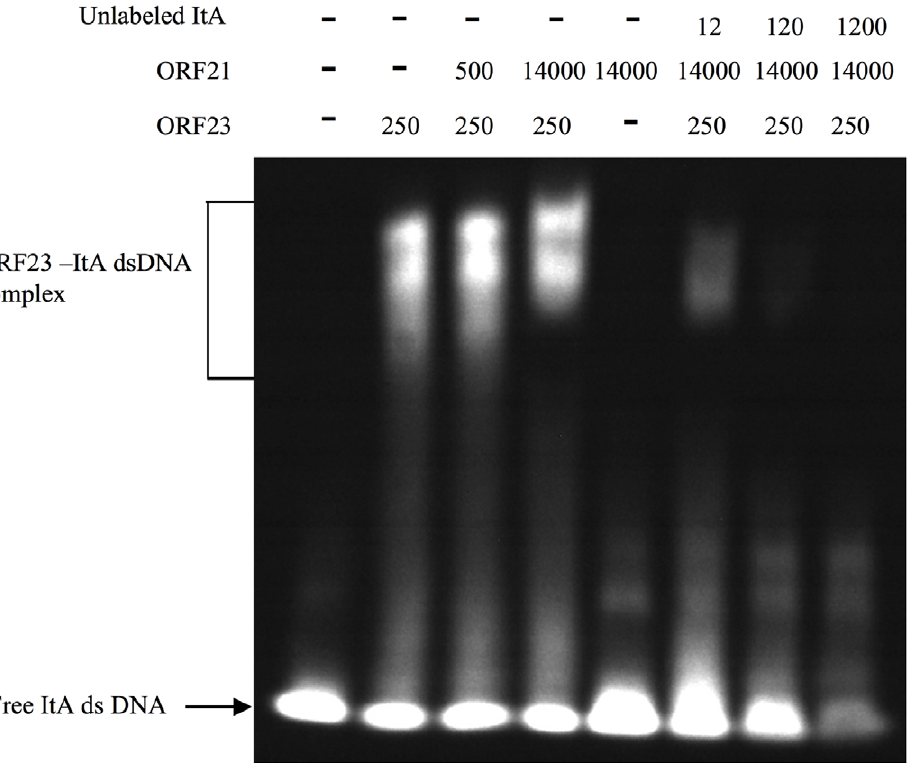
Figure 8. Binding of purified ORF21 and ORF23 to the ItA fragment. ItA was incubated with purified ORF23 and/or ORF21, the amounts of which are described at the top of the figure (ng). Indicated amounts of unlabeled ItA (pmol) was added to show the competition. The concentration of labeled DNA used in each lane was 12 pmol.